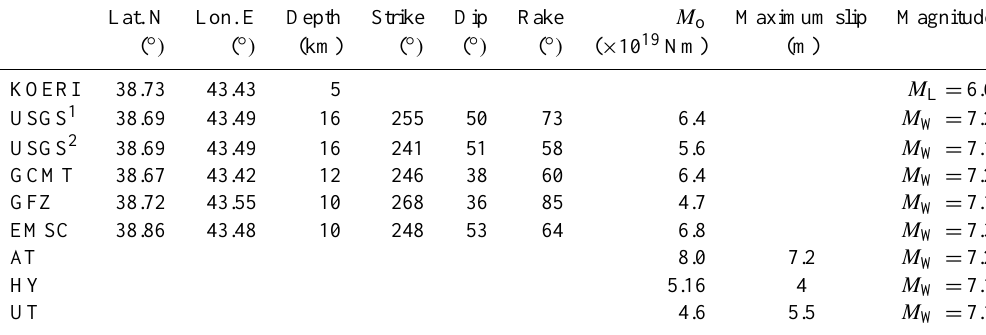
Table 1. Source parameters of the 23 October 2011 Van earthquake. Lat. N Lon. E Depth